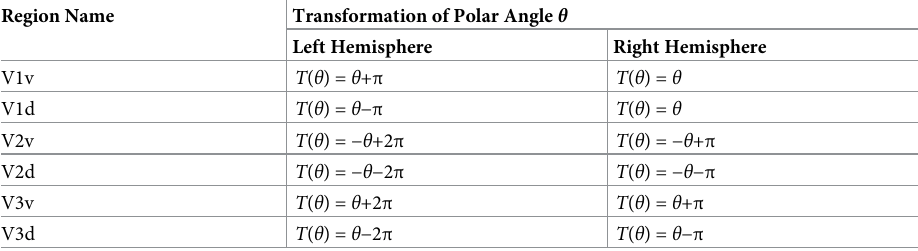
Table 1. Polar angle transformations are used to remove phase-jumping and changes of visual field sign for the left and right hemispheres in multiple visual